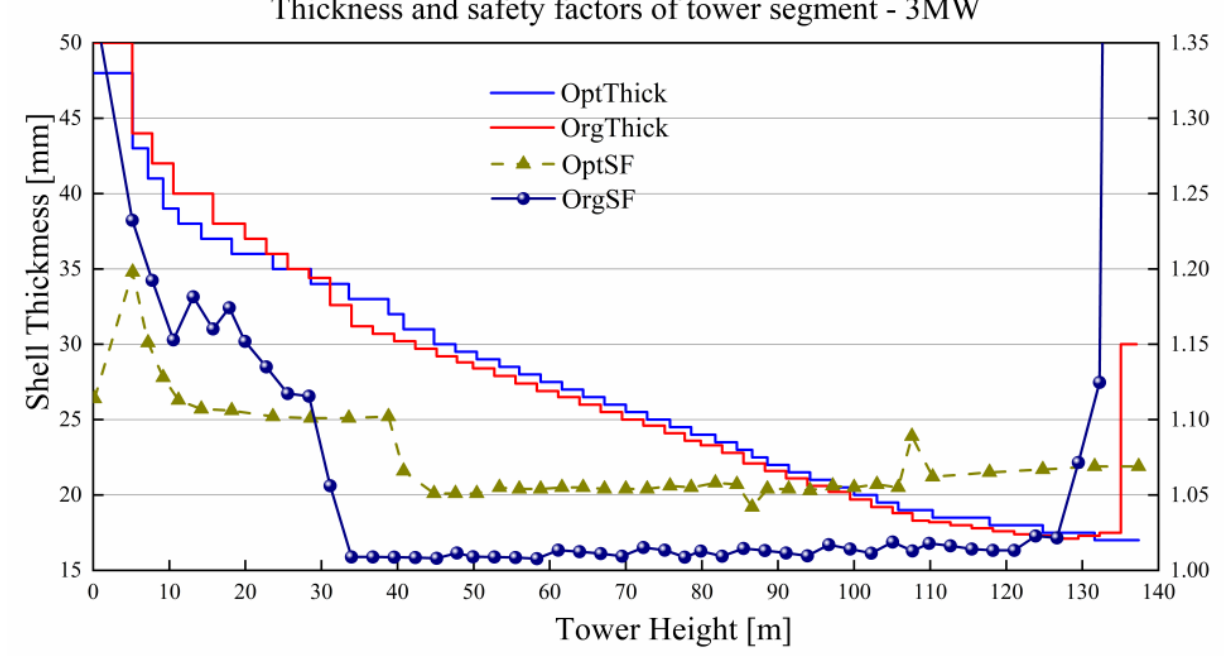
Figure 5. Thickness and safety factors of original and optimum 3 MW tower segments. As can be seen from Table 3, the thickness of the initial tower design changes rather slowly, which leads to a great many segments. After optimization, the number of segments is reduced. According to Figure 5, the designed safety factor level of tower segment is higher than that of the original, so the optimum mass of tower shell is larger relative to the original. As door opening undermines the stability of tower segment and tower thickness cannot reduce rapidly, sections except tower bottom and the minimum safety turning region are generally designed with constant strength and rigidity. Parameters and safety factors of bolted connections and flanges are shown in Figure